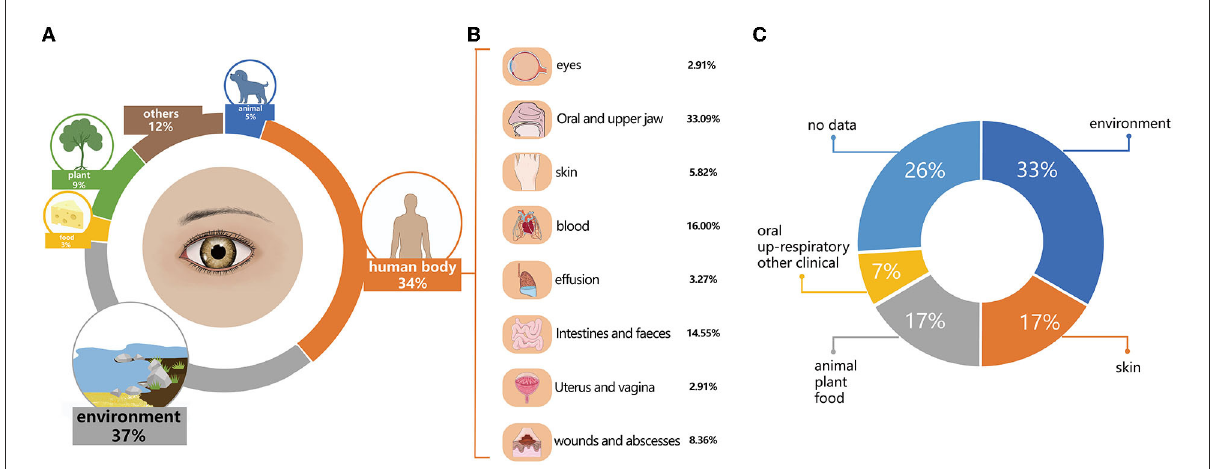
FIGURE4 The initially isolated origin and potential pathogens in named species. (A) The initial isolation origin of named species detected by metataxonomics. (B) The initial isolation origin of named species isolated by culturomics. (C) The potential pathogenic species in named species detected by